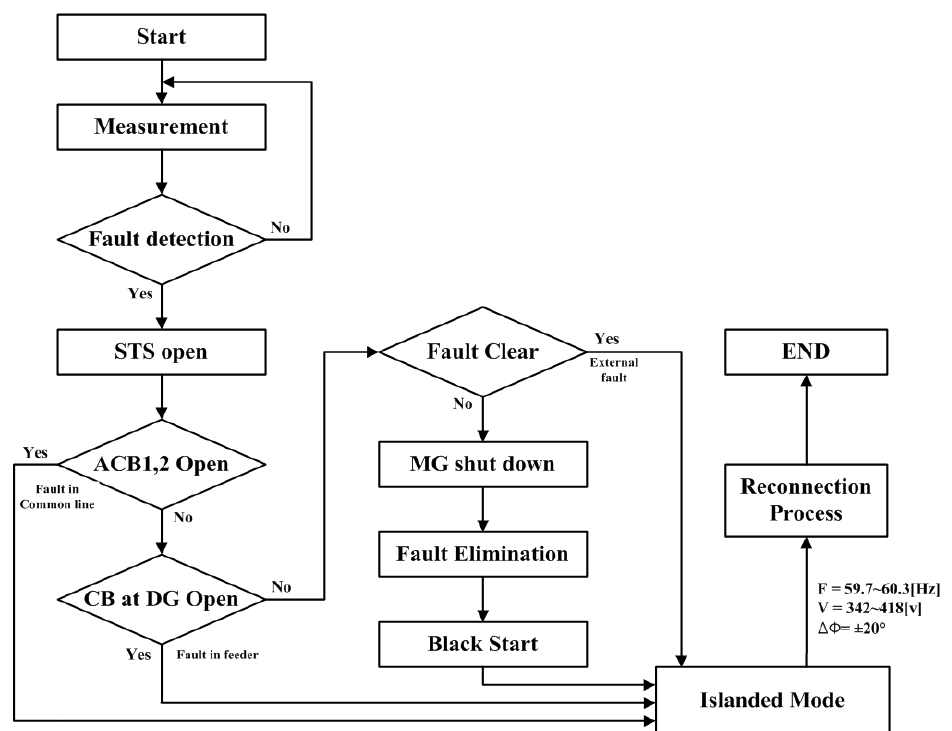
Figure 5. Flowchart of the protection algorithm for secondary microgrid (Zones A and